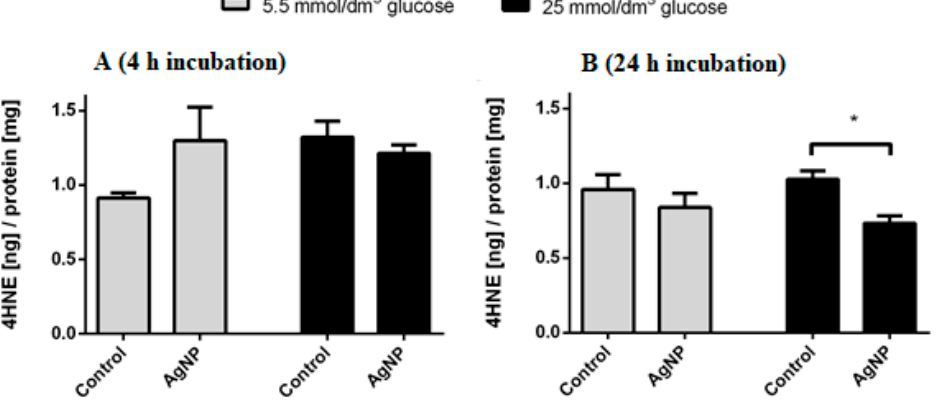
Figure 5. HNE content of cells cultured at different glucose concentrations (ELISA). The cells were subjected to a 4 h ( A ) and 24 h ( B ) treatment with silver nanoparticles (12.5 µg/cm 3 ), untreated cells performed as the control; * denotes a statistically significant difference with respect to the control, Student’s t-test, n = 3, α = 0.05.